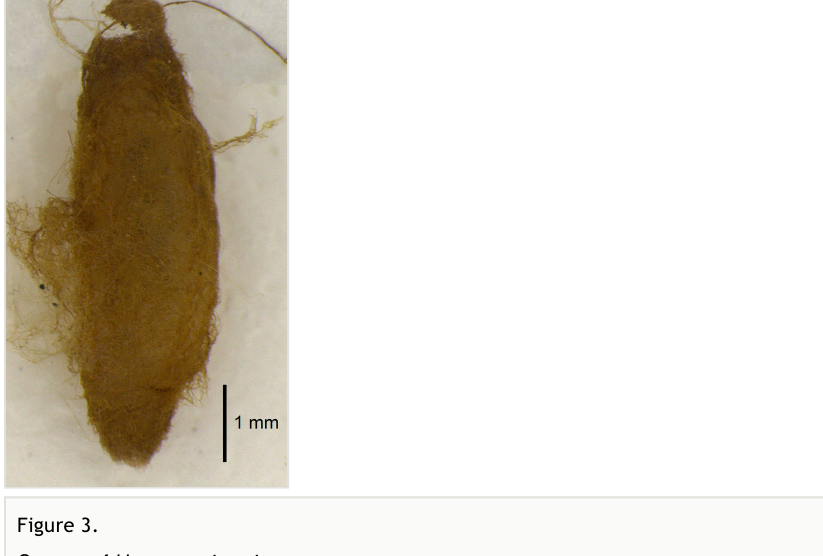
Cocoon of Hymenoepimecis manauara .